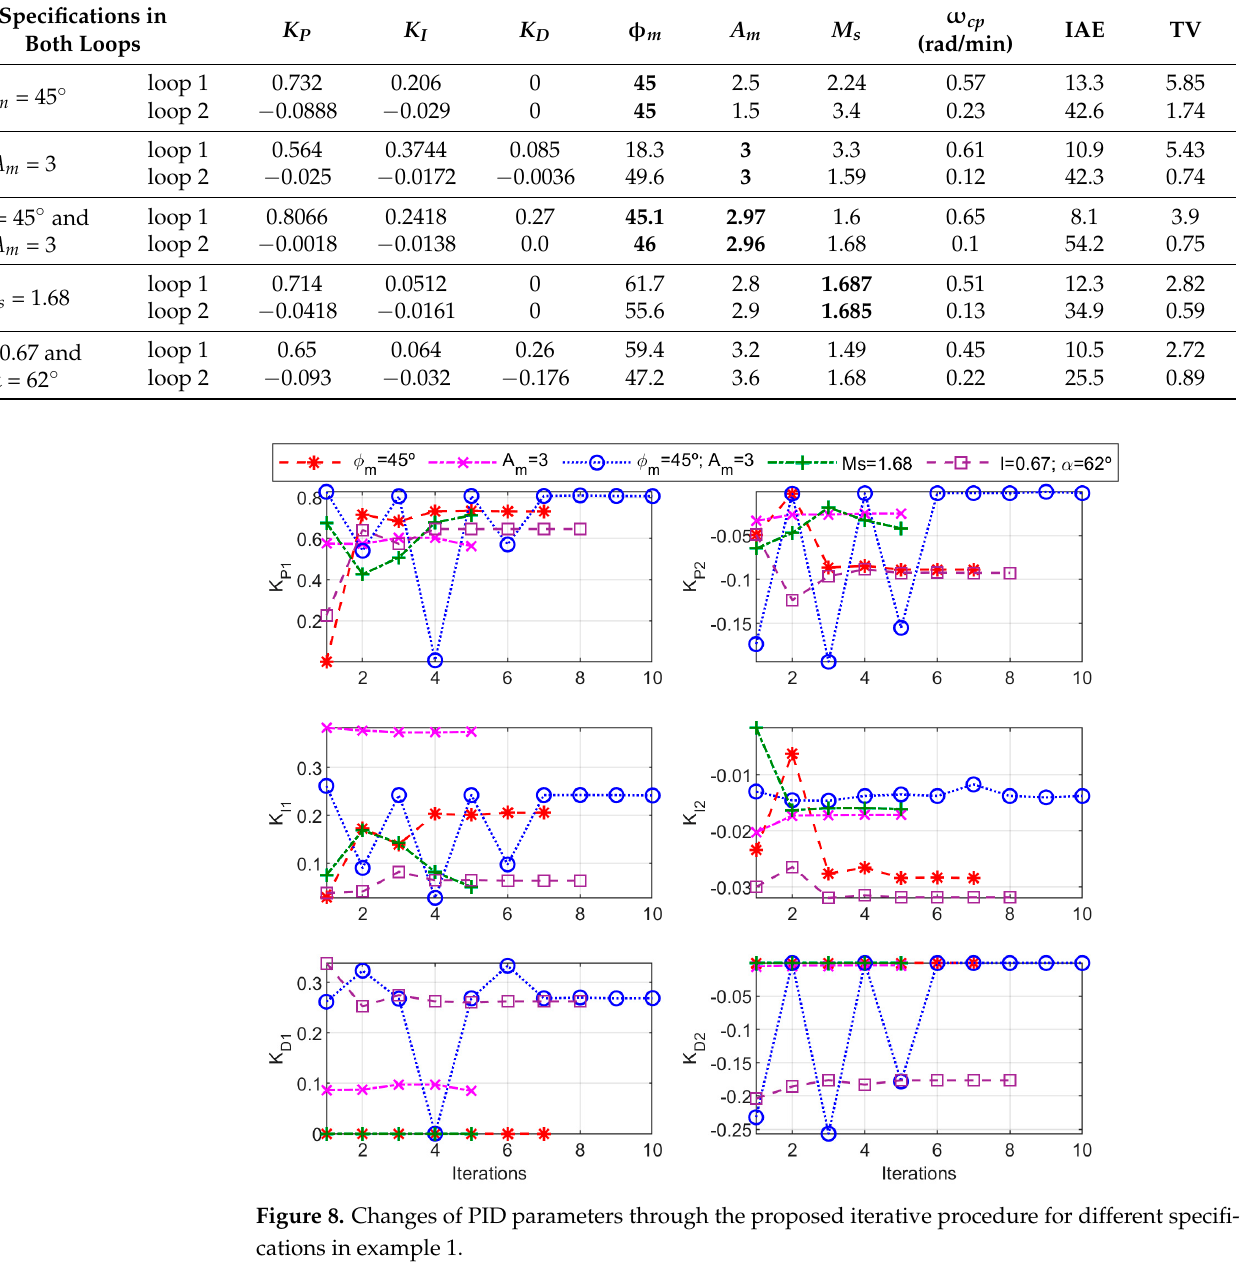
Figure 9. Progression of the design specifications and cost index through the proposed procedure in example 1.